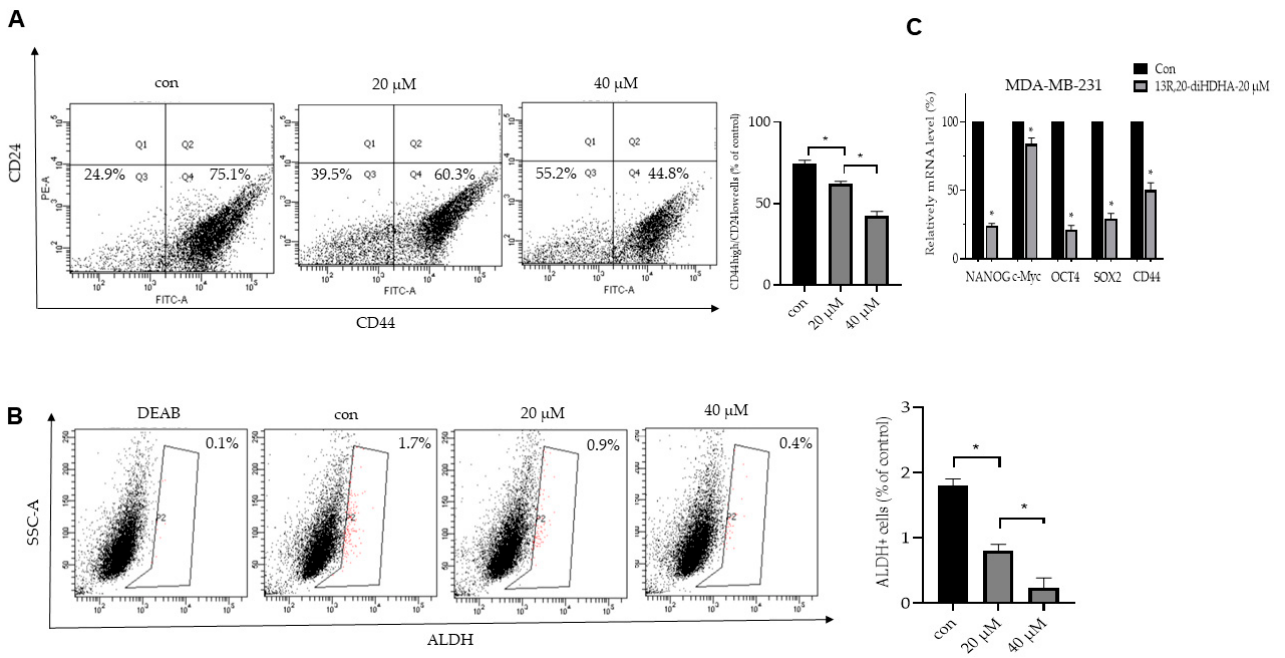
Figure 3. The effect of 13R,20-diHDHA on the CD44 high /CD24 low and aldehyde dehydrogenase (ALDH)-positive cell proportions. ( A ) The CD44 high /CD24 low cell populations of MDA-MB-231 cells treated with 13R,20-diHDHA (20 or 40 µ M) or DMSO for 24 h were analyzed by FACS. The gating was based on binding of a control antibody. ( B ) 13R,20-diHDHA decreased the ALDH-positive cell population, as detected with an ALDEFLUOR™ kit (Vancouver, BC, Canada). Breast cancer cells were treated with 13R,20-diHDHA (20 or 40 μ M) for 24 h and subjected to FACS analysis. Representative flow cytometric data are shown. The left panel shows the ALDH-positive population in the presence of the ALDH inhibitor, DEAB, and the right panel represents the ALDH-positive population without DEAB. ( C ) Transcript levels of the CSC markers, Nanog, Sox2, Oct4, c-Myc, and CD44, were determined in 13R,20-diHDHA-treated mammospheres using gene- specific primers and real-time RT-qPCR. β -actin was detected as an internal control. The data from triplicate experiments are presented as the mean ± SD. * p < 0.05 versus the DMSO-treated control group.